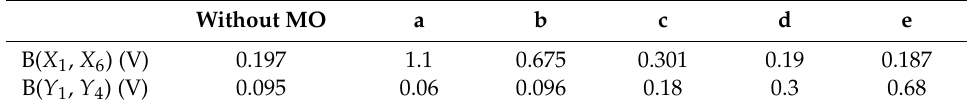
Figure 14. V AB according to MO’s position ( a ) MO position in a balanced coil, ( b ) measured V AB . Table 3. V AB according to MO’s position.